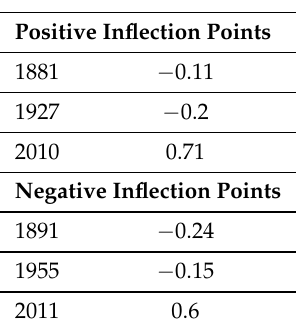
Table 3. Positive and negative inflection points of the Land and Ocean anomalies.